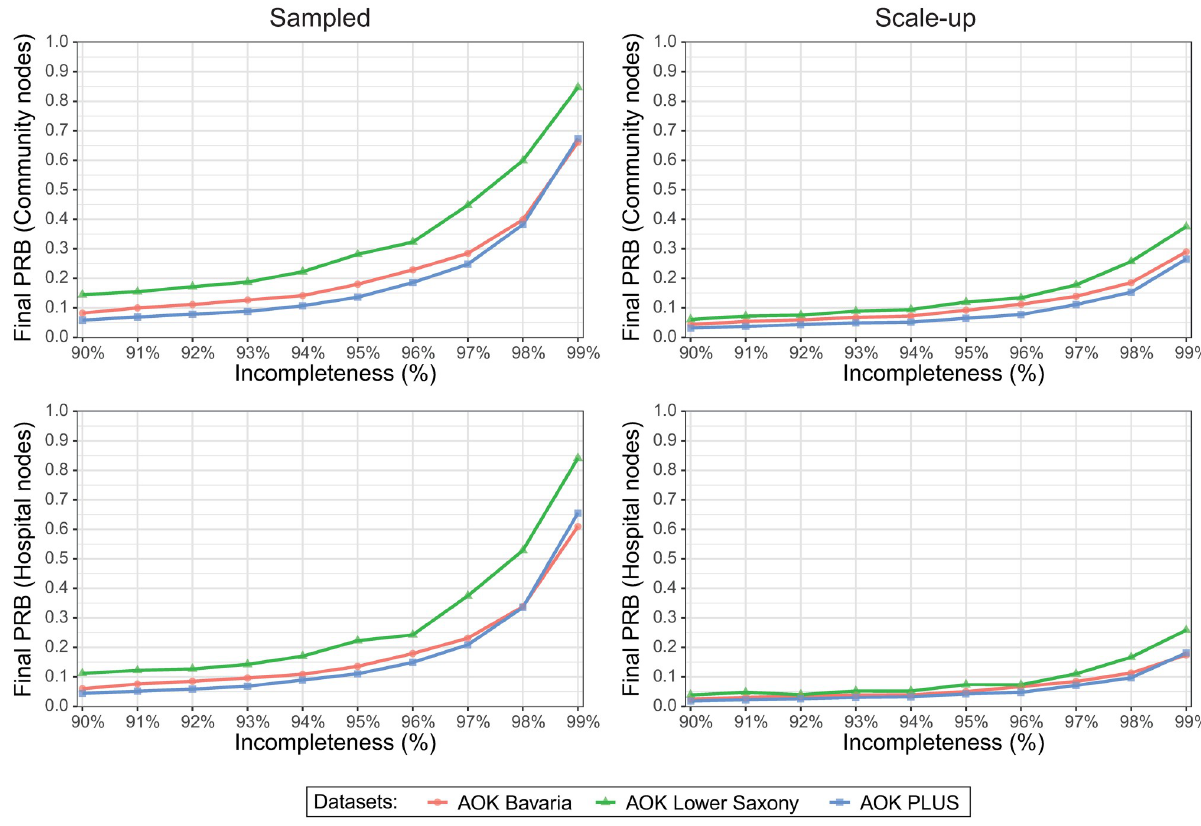
Fig 5. Final PRBs of simulated networks for each AOK plotted against percentage of